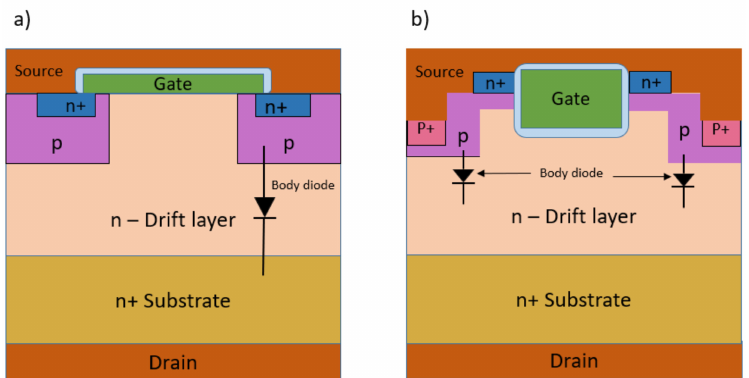
Figure 14. The location of body diode in ( a ) DMOSFETs and ( b )